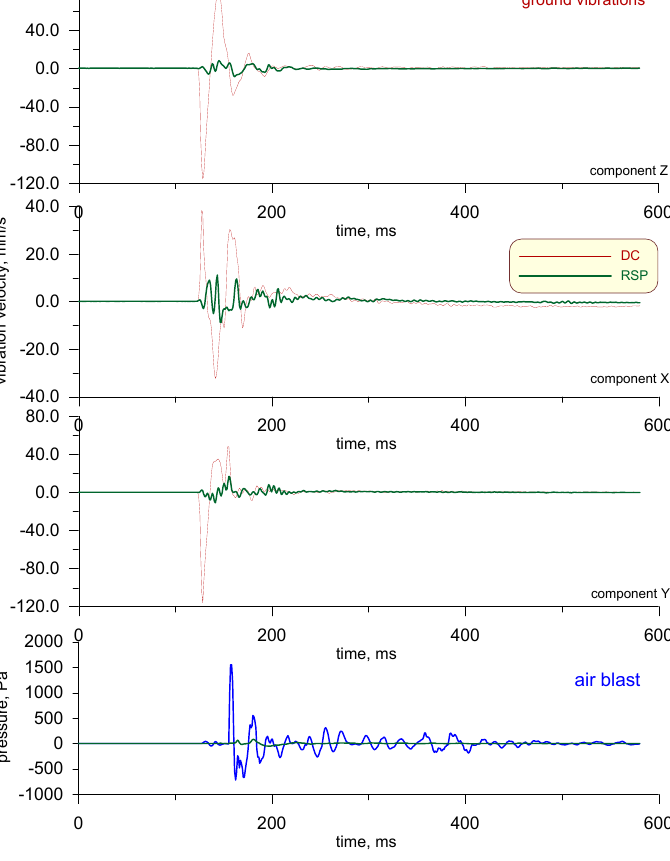
Figure 12. Result of the third octave analysis for air blast at station M1. Analyzing Figure 11, one can see a clear difference in the intensity of vibrations induced by the primer cord detonation, and RSP-generated combustion. Vibrations induced using RSP, in individual third octave bands are much smaller. The distribution frequency is similar, but it is determined by the geological structure and immediate firing in both cases (no signal interference, which is usually caused by firing with a delay). The frequency structure of the air blast record may suggest a significant interaction of the acoustic wave (in order to better compare the air blast structure, the detonation cord values were divided by 12). 6. Discussion The use of gas generators in extraction of rock blocks is an alternative method for those currently used. The use of an appropriate pyrotechnic mixture requires optimization of its thermodynamic parameters. In the next, they should be tested and allowed to be used in quarries. At the end, the distribution of gas-generating equipment should be adapted to local geological conditions. Based on the results of preliminary experimental tests and numerical estimates, a composition of the pyrotechnic mixture was selected, which was used as the active element in the gas generator